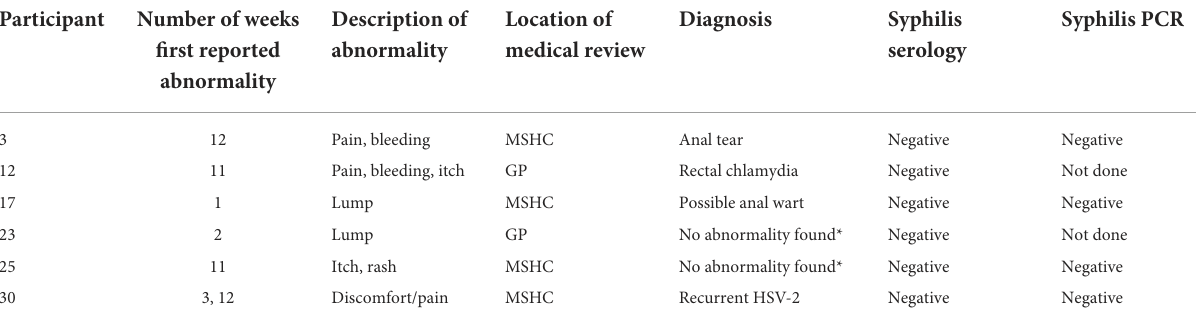
MSHC,MelbourneSexualHealthCenter. GP,GeneralPractitioner. HSV-2,HerpesSimplexVirusTypeII.